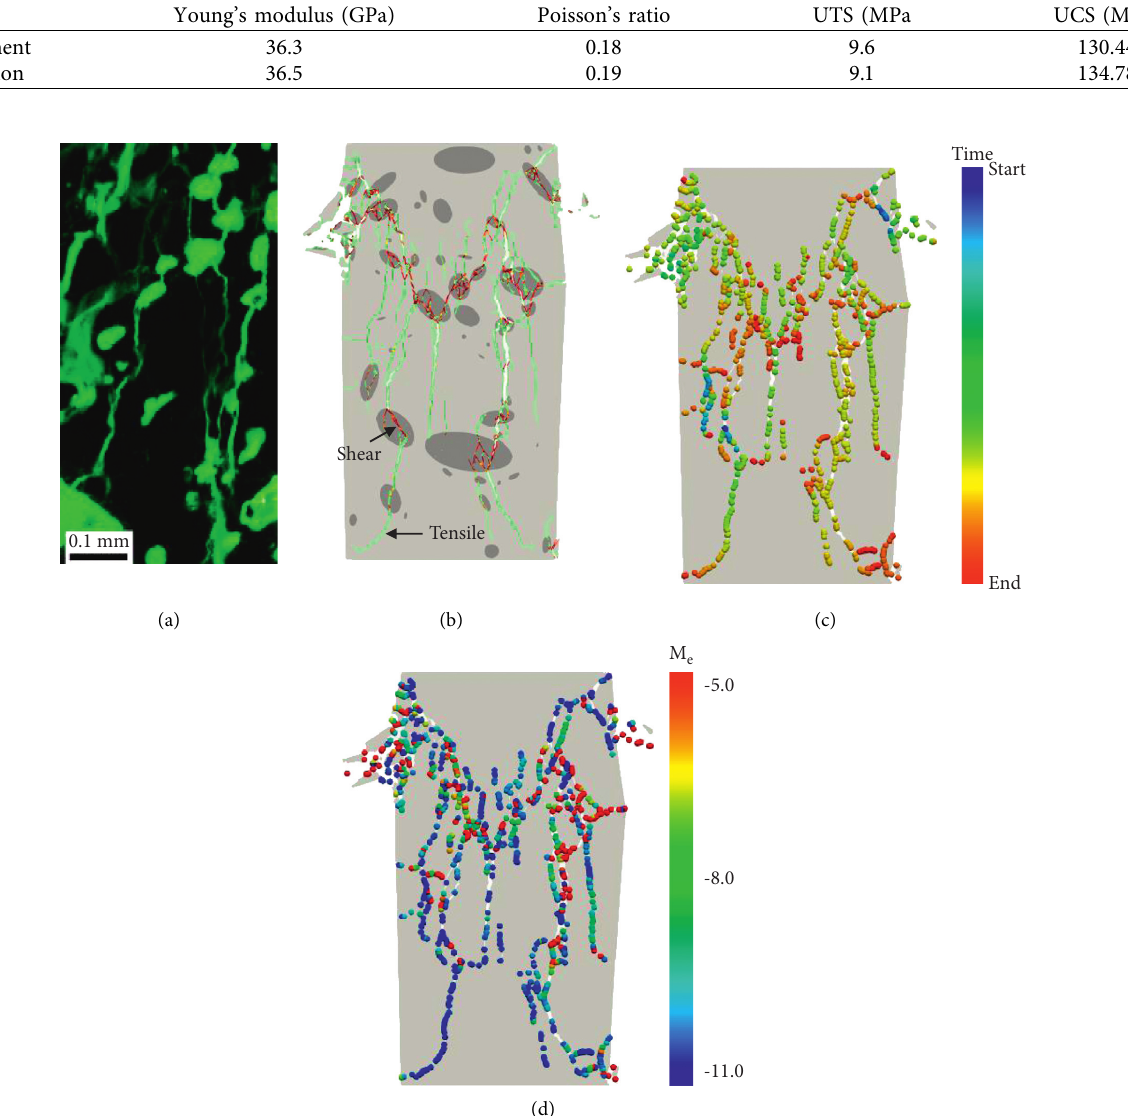
Figure 7: Fracture evolution under the uniaxial compression experiment and simulation: (a) The failure phenomenon of andesite samples during the laboratory test [25]. (b) The failure phenomenon of the numerical sample of amygdaloidal basalt; green � tensile crack and red � shear crack. (c) AE evolution. (d) AE events’ energy, M e , measured based on the kinetic energy of the AE